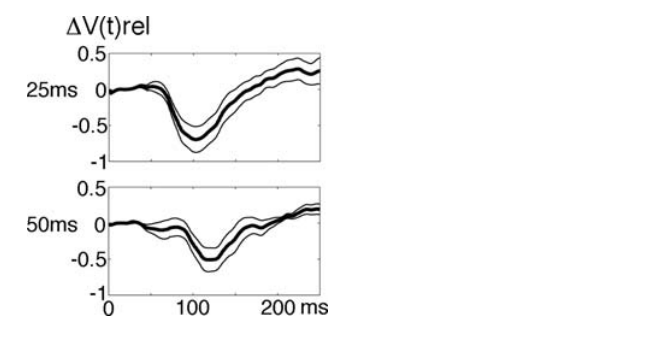
Figure 5. Non-linearity of the 25 ms and 50 ms D V(t). The normalized ON and OFF responses from the 250 ms condition were subtracted from the actually measured D V(t)rel for the 17/18 representation of the square. The curves were calculated as follows. First the D V(t)rel was calculated for each animal and stimulus condition (methods). Then the OFF response from the 250 ms condition was cut